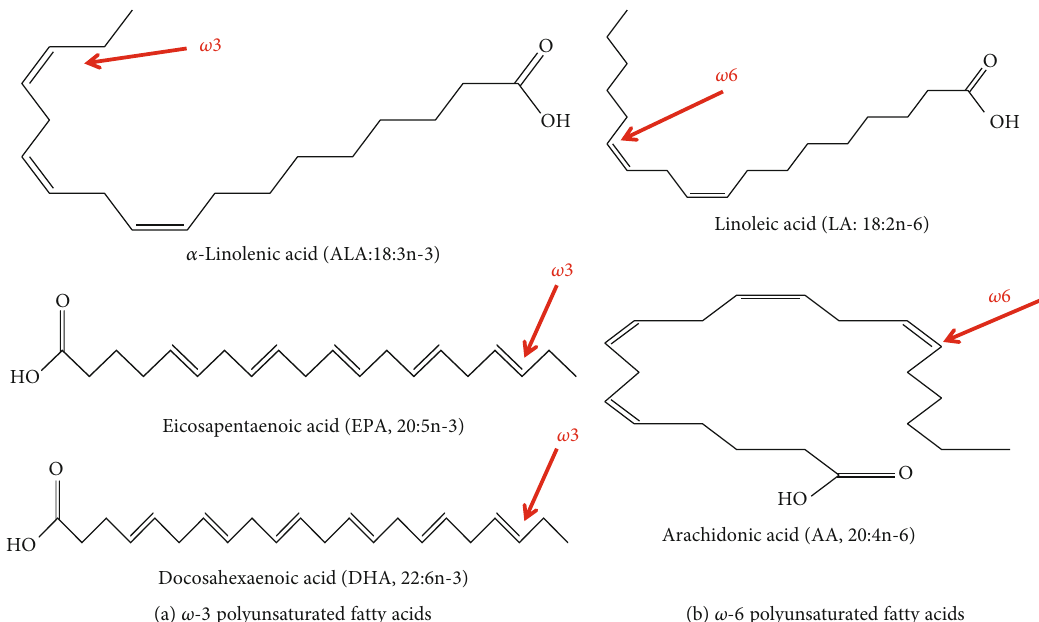
Figure 1: The most nutritionally important n-3 and n-6 PUFAs and their chemical structure. (a) n-3 PUFAs. (b) n-6 PUFAs. Adapted from Saini and Keum [12].